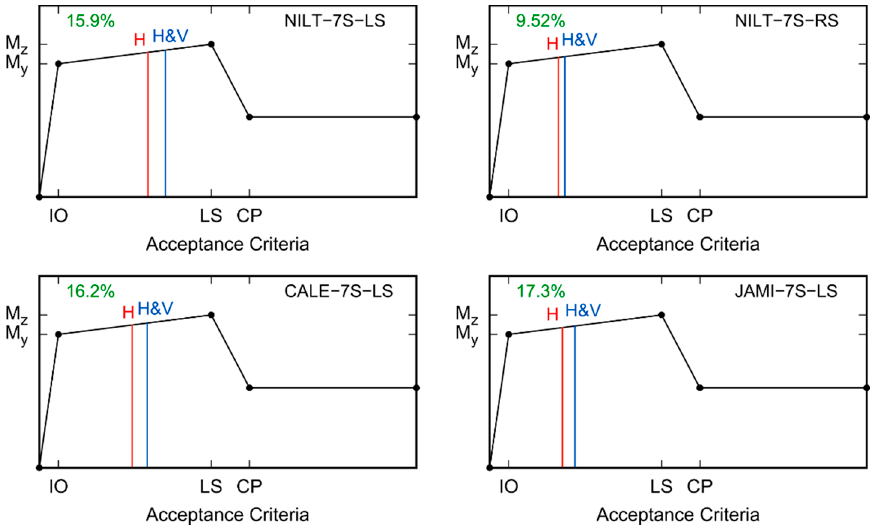
Figure 23. Non-linear response of the outer-most fiber in the considered beam for different earth- quakes; 8-story building (Part 3).